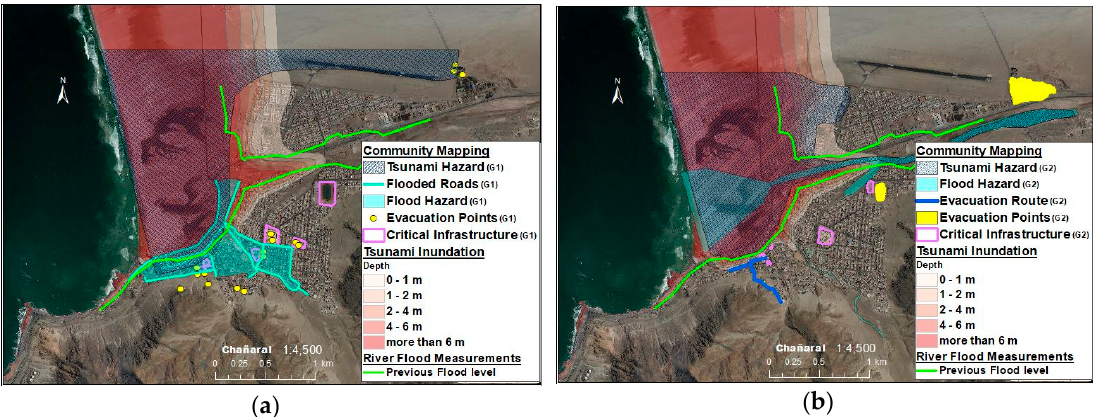
Figure 16. Simulated and perceived hazard maps: ( a ) Group 1, ( b ) Group 2.